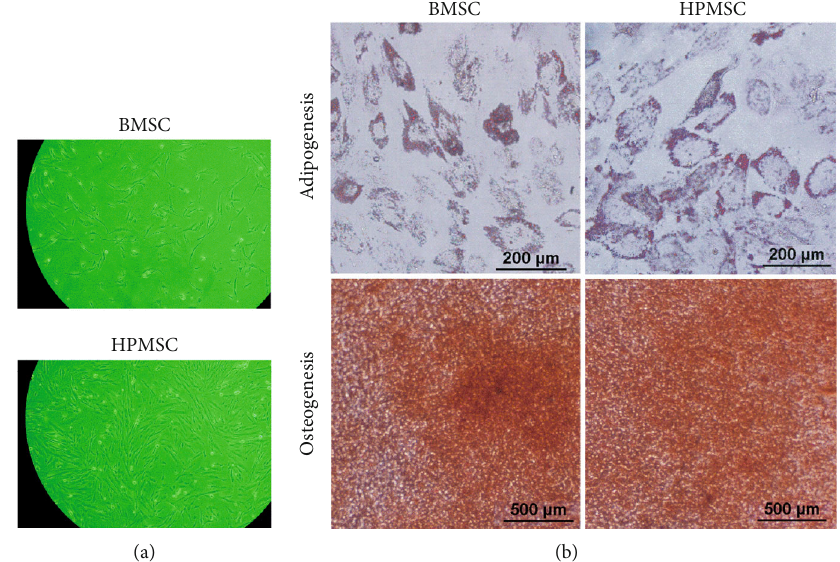
Figure 2: (a) The morphological characteristics of two types of MSCs observed under a microscope (100x): a fi broblast-like long-spindle shape, adherent and vortex-shaped growth, and orderly arrangement. (b) Staining for the induction of adipogenic and osteogenic di ff erentiation of two types of MSCs.